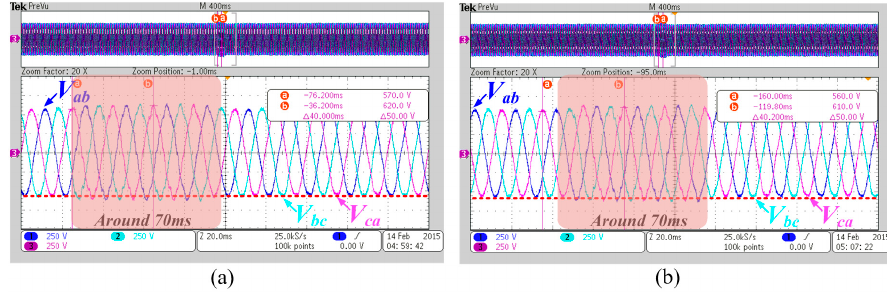
Figure 4. Real time voltage waveform: ( a ) details at t 3 ; and ( b ) details at t 4 .